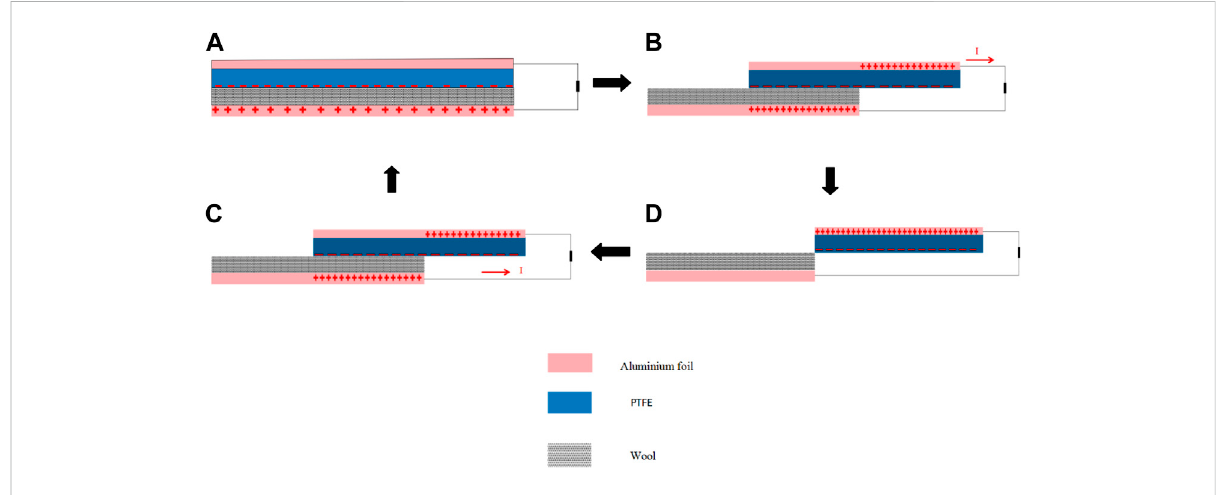
FIGURE 3 Schematic diagram of an operation cycle of